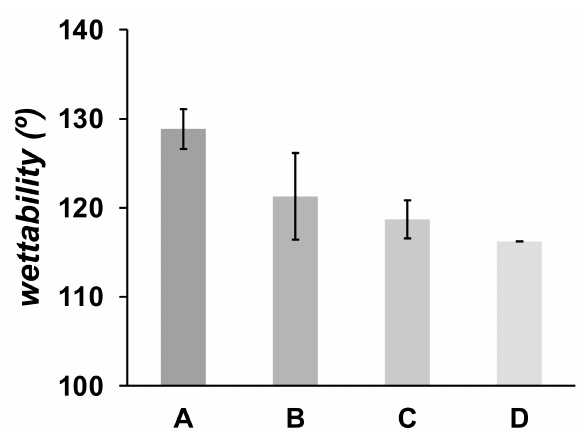
Figure 5. Wettability of electrospun fibers. (A) PLA10, (B) PLA/PEG, (C) PLA/PEG/2.5HA, and (D)